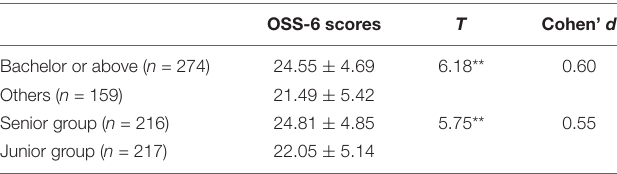
TABLE 5 | Group differences in OSS-6 scores ( x ±